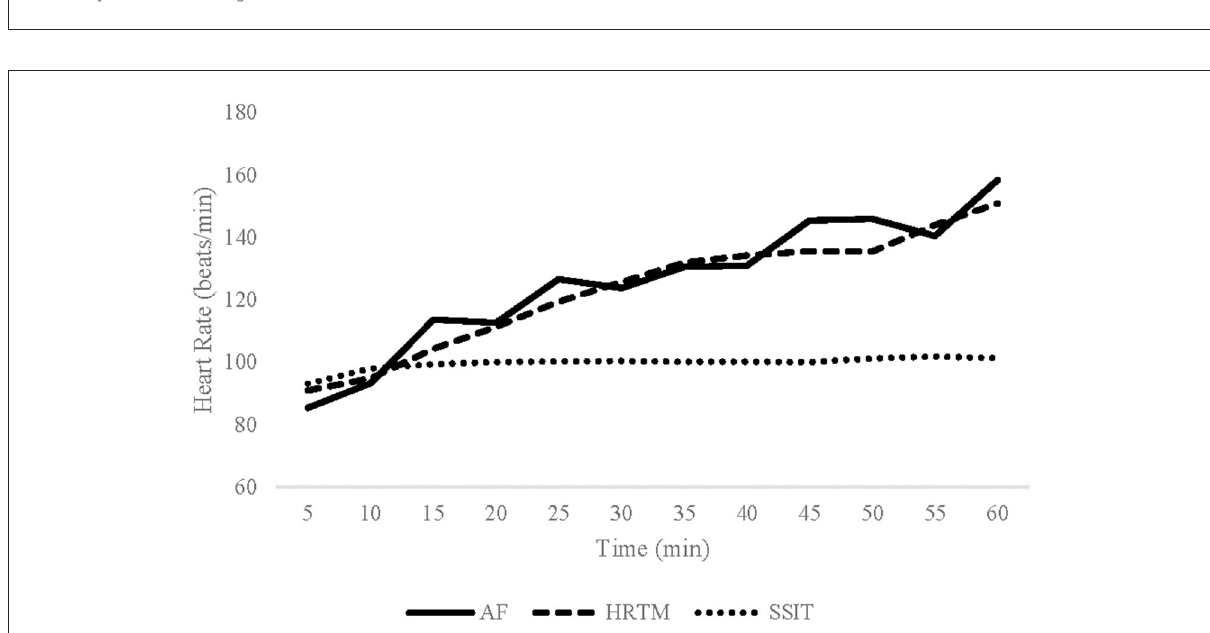
FIGURE2 Average heart rate (bpm) responses across each condition (AF, HRTM, SSIT). AF, Animal Flow; HRTM, heart rate matched treadmill walking; SSIT, self-selected intensity treadmill